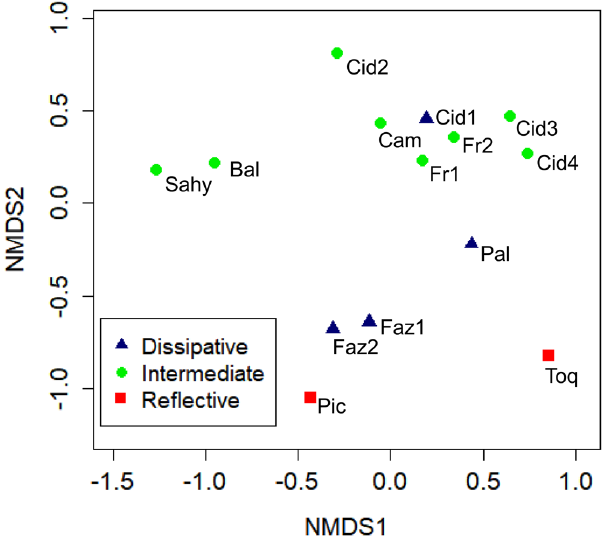
Figure 1. Dissimilarity in community composition among sampled beaches. NMDS stress = 0.109. Refective beaches: Toque-Toque (Toq) and Picinguaba (Pic); Intermediate beaches: Barra do Sahy (Sahy), Baleia (Bal), Flecheiras 1 and 2 (Fr1 and Fr2), Cidade 2 to 4 (Cid 2 to Cid4) and Camaroeiro (Cam); Dissipative beaches: